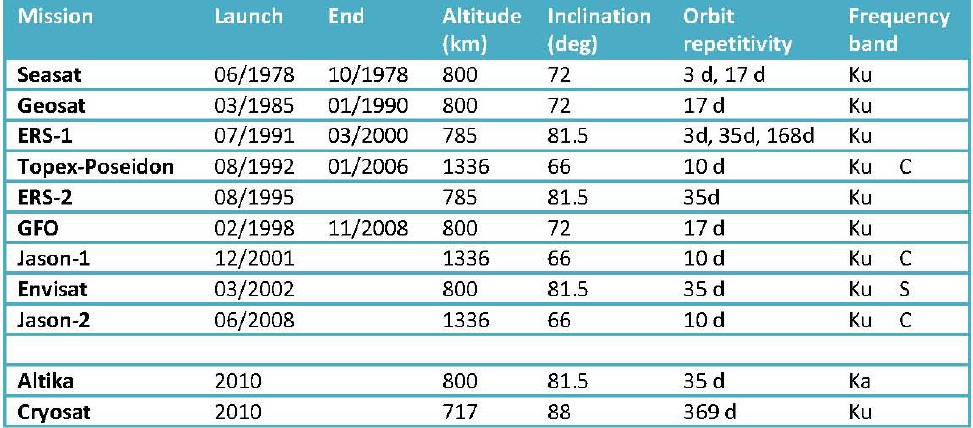
Table 1. Altimetric missions with altitude, inclination, repetitivity and wavelength band (Ku, 13.6 GHz; C, 5.6 GHz; S, 3.2 GHz; Ka, 37 GHz) with respect to launch. Two future missions planned to be launched in 2010 are also